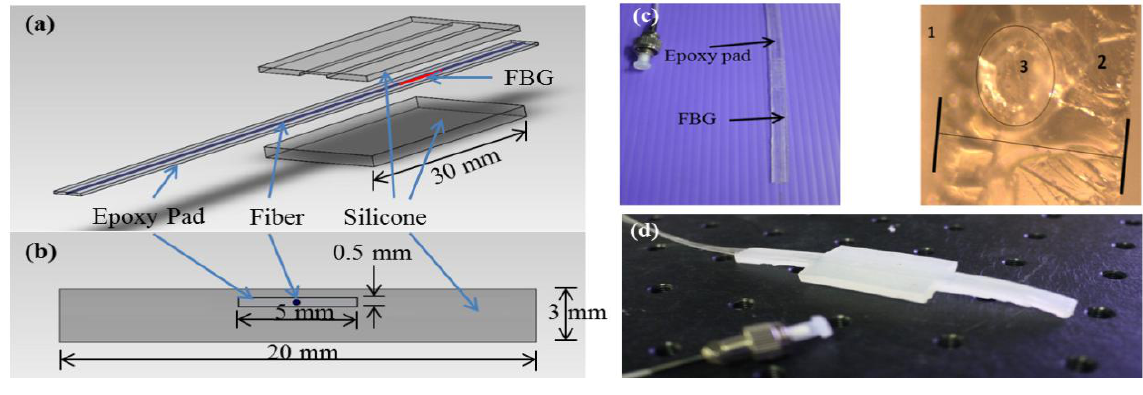
Figure 2. Structure of the pressure sensor. The epoxy pad (the strip-like pad shown in ( a )) was placed between the upper (1 mm thick) and the lower (2 mm) sheets of silicone materials to form the pressure sensor. ( b ) The sensor cross-sectional area is 20 × 3 mm 2 and the dimensions of the whole sensor were 30 × 20 × 3 mm 3 , and the sensitive surface area was 20 × 30 mm 2 . ( c ) Images of the epoxy pad and its microscopic cross-sectional area. ( d ) The image of the whole pressure